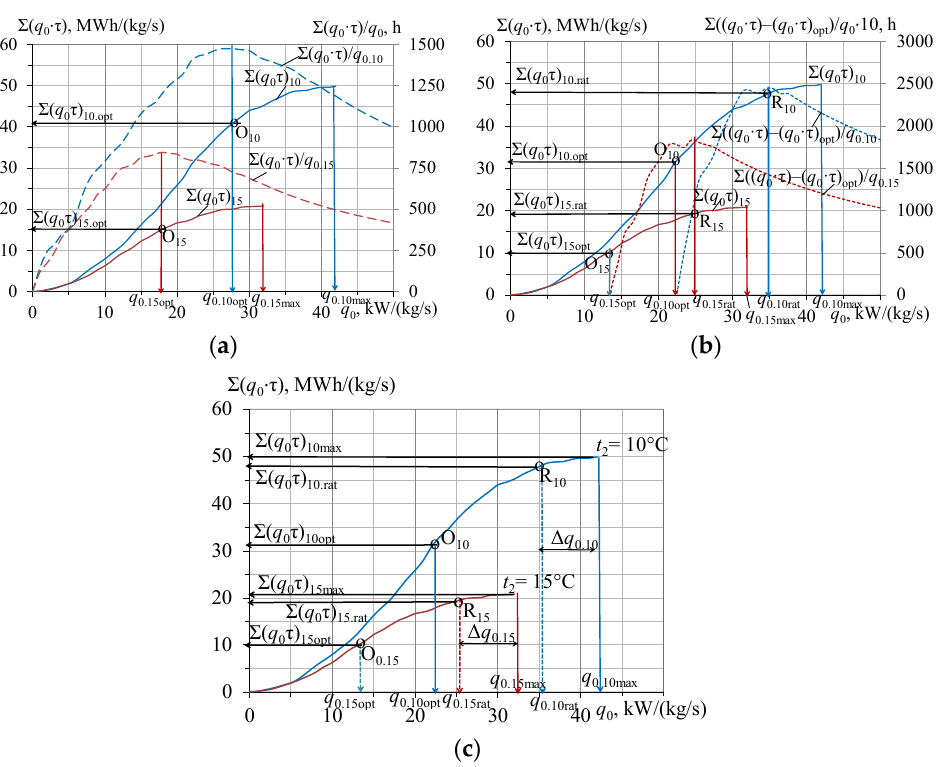
Figure 1. Specific annual refrigeration energy consumption ∑ ( q 0 · τ ), optimum q 0.opt and rational q 0.rat values of specific refrigeration capacities while cooling ambient air to 10 and 15 ◦ C in southern Ukraine (temperate climate), 2017: ( a ) determining of q 0.opt ; ( b ) determining of q 0.rat ; ( c ) generalized graphs for q 0.opt and q 0.rat ; ∆ q 0.10 = q 0.10max − q 0.10rat and ∆ q 0.15 = q 0.15max − q 0.15rat